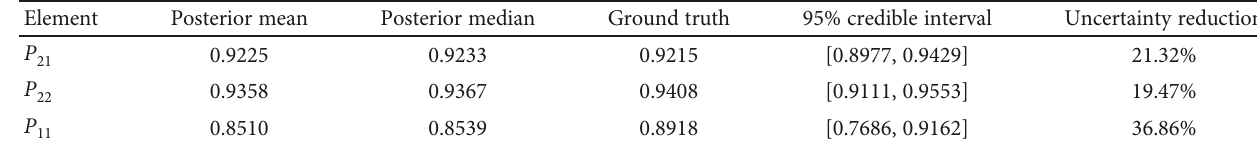
Figure 10: Comparisons of probability indexes of E (a), E (b), and E (c). True parameter value (vertical line), less information 21 22 11 aggregated (using only system-level information, dotted curve), more information aggregated (using both system-level information and sub-system-level information, dashed curve), and full information aggregated (using all available information, solid curve). Table 8: Statistical results of posteriors for the subsystems and the whole system.